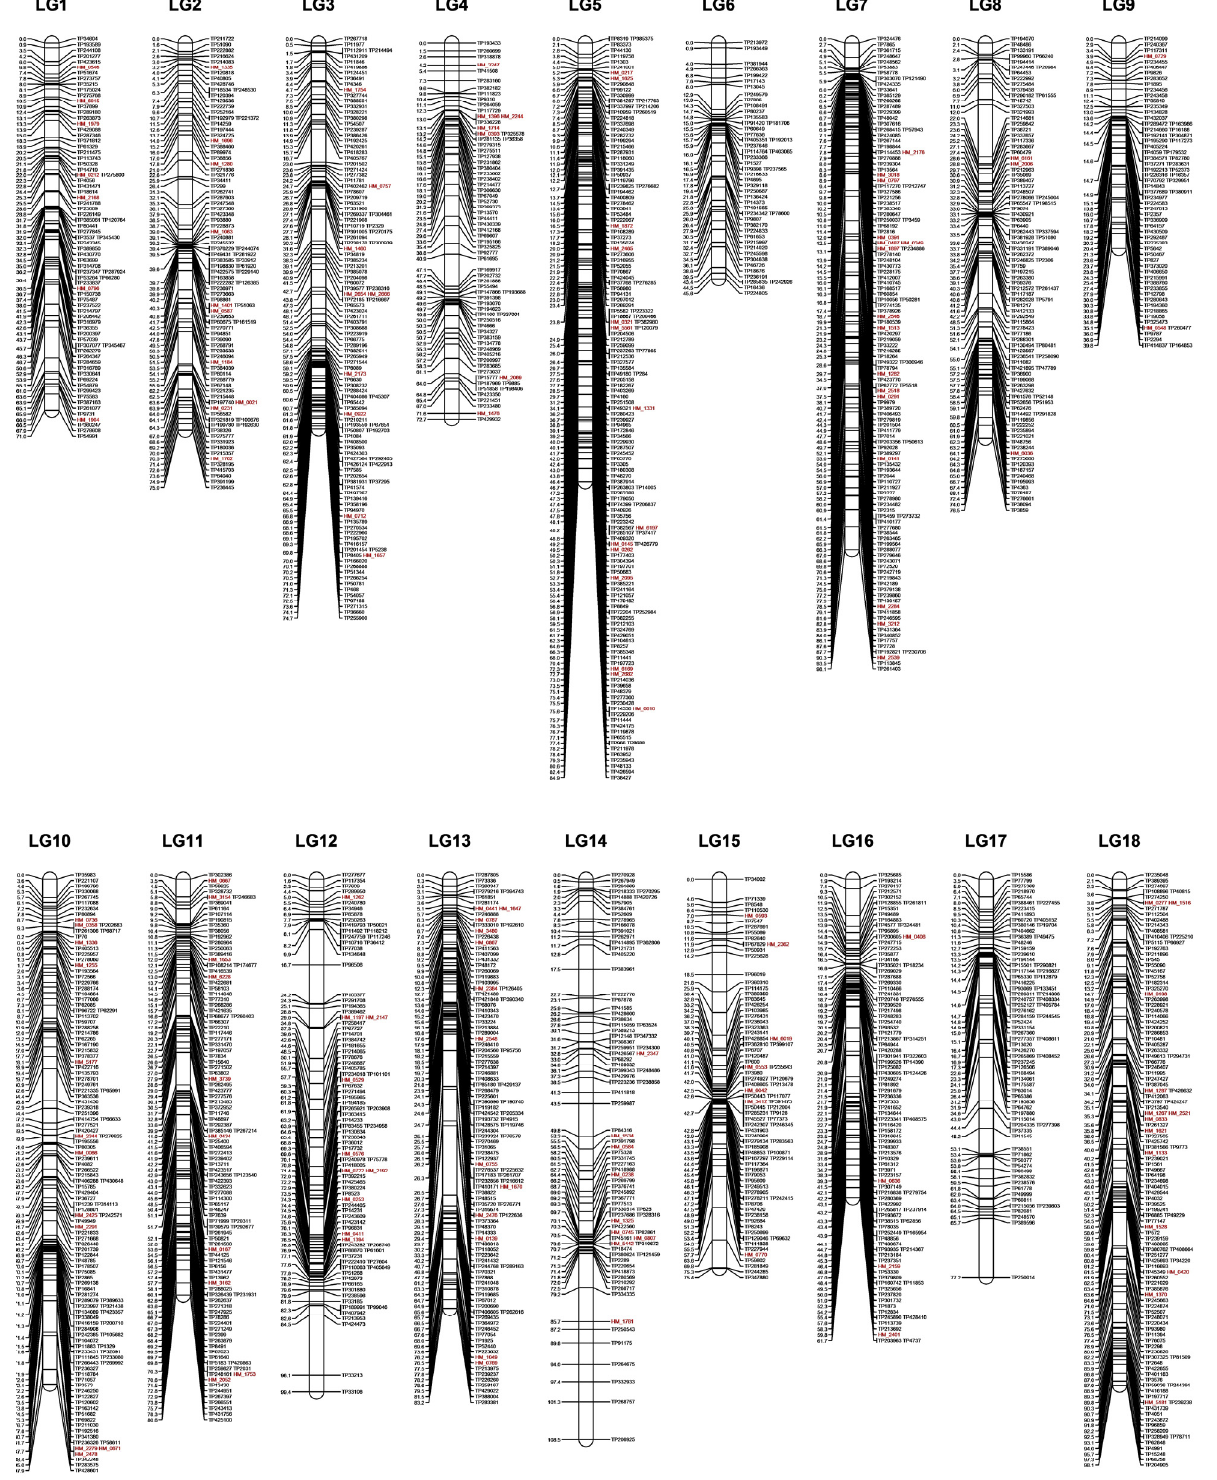
Figure 2. SSR- and single nucleotide polymorphism (SNP)-based high-density genetic consensus linkage map of H. macrophylla . A total of 1621 SNP markers ( black ) and 146 SSR markers ( red ) are shown in 18 linkage groups.